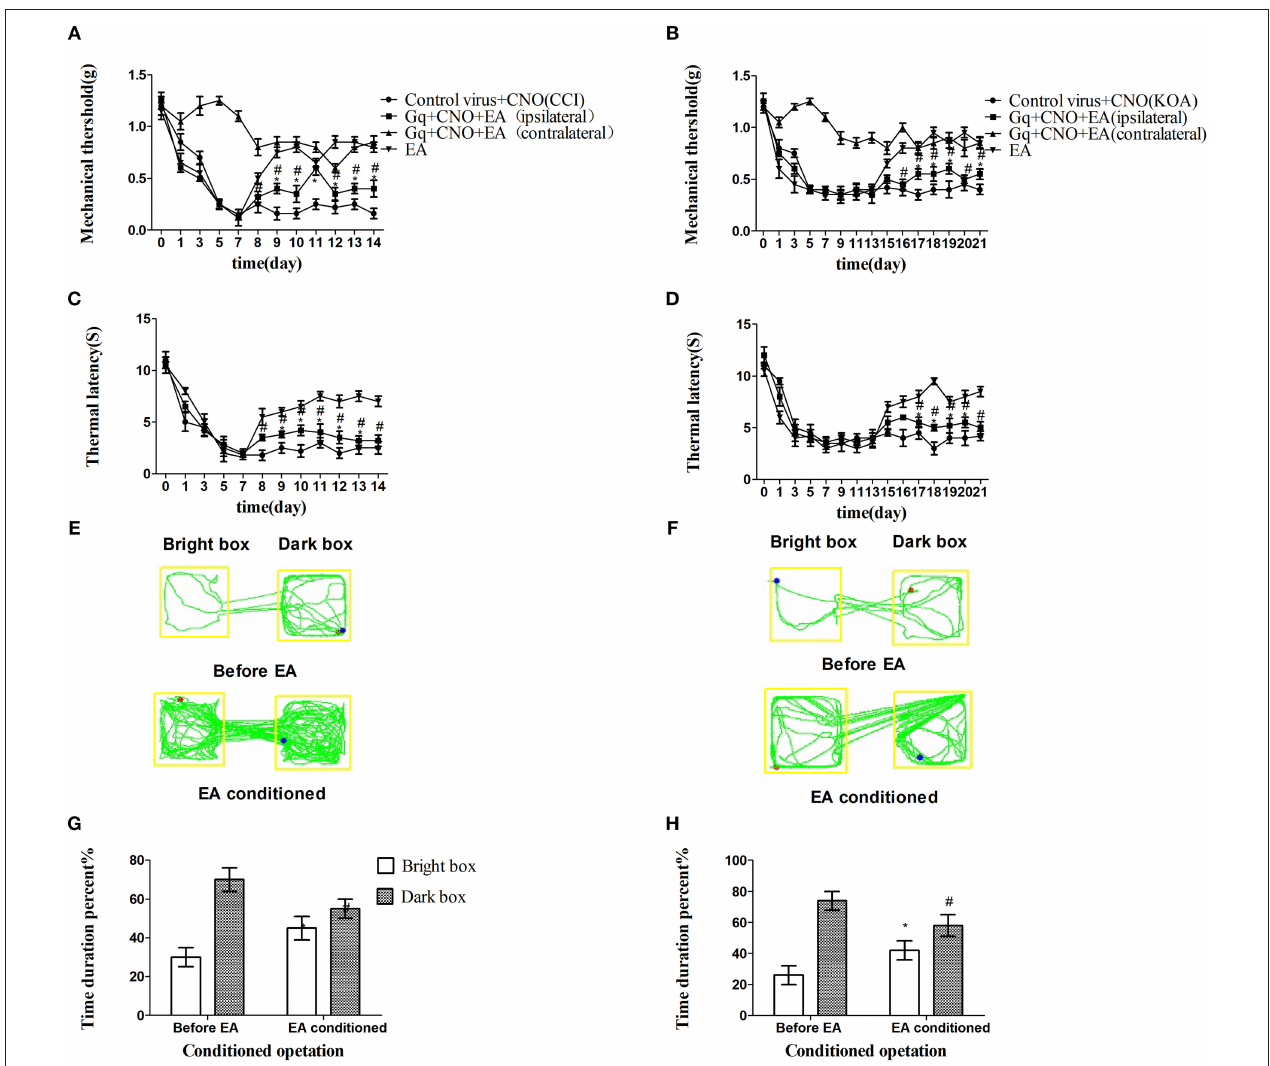
FIGURE 4 | Chemogenetic activation of GABAergic neurons in the vlPAG only partly attenuated the effect of EA. (A,B) Time course of tactile threshold in response to von Frey filaments. (C,D) The noxious heat stimulus (53 ◦ C) caused a change in the thermal thresholds. Tactile (A) and thermal (C) withdrawal thresholds changes in CCI mice after chemogenetic activation. Changes in tactile (B) and thermal (D) withdrawal thresholds of KOA mice caused by chemogenetic activation. Motion map of chemogenetic activation of conditioning in the CPP test with CCI (E) and KOA mice (F) . G,H are summary values of motion trajectories. Virus was injected 21 days before the behavior test. CNO (1 mg/kg) was administered once a day starting from the 8th to the 14th day in the CCI model and starting from the 15th to the 21st day in the KOA model. EA (1mA and 0.1ms) at 2Hz was administered for 30min. Once a day starting from the 8th to the 14th day in the CCI model and starting from the 15th to the 21st day in the KOA model, all behavior tests were completed 2h after CNO administration. Control groups consisted of CCI or KOA mice injected with control virus and CNO but without EA treatment. Data are expressed as means ± SEM ( n = 12 in each group). In A–D , * p < 0.05, compared with control group; # p < 0.05, compared with the model group; In G,H ,* p < 0.05, compared with the bright box time duration percent before chemogenetic activation; # p < 0.05, compared with the dark box time duration percent before chemogenetic